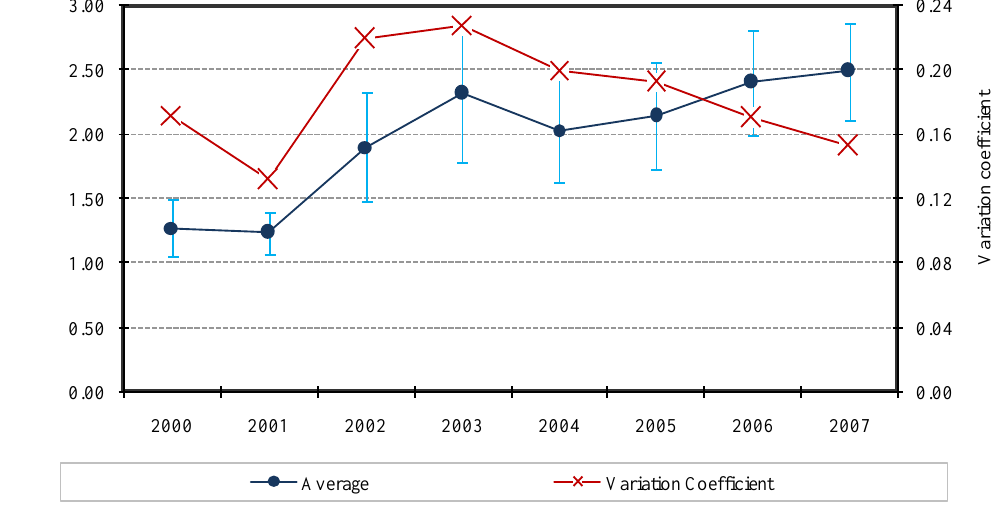
Figure 9. Level and variation of agricultural output value (UZS ha −1 ),